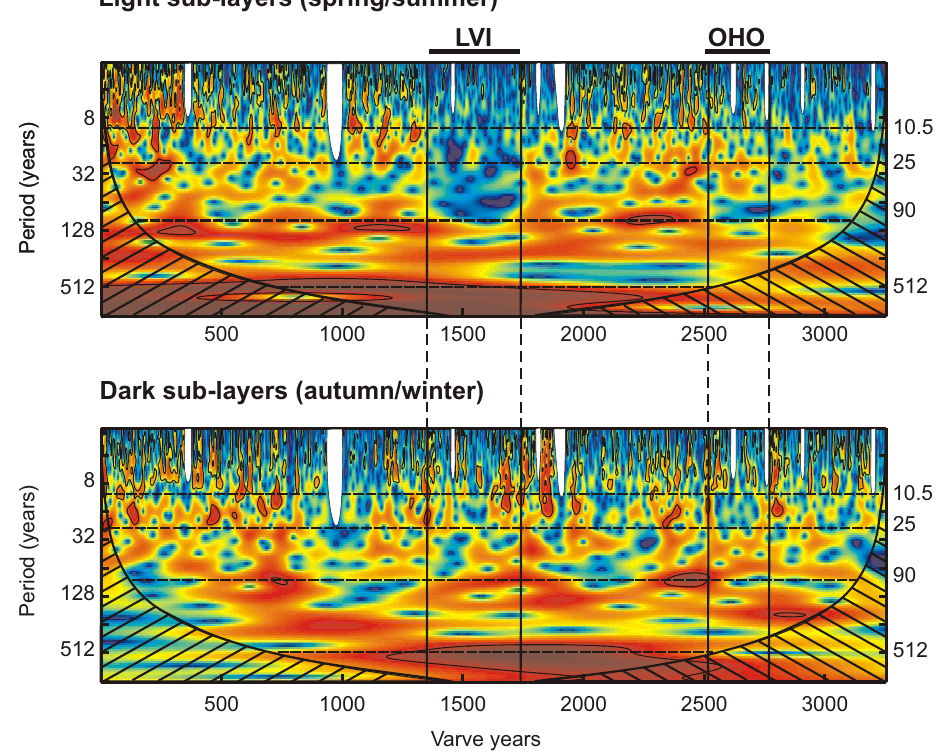
Fig. 6. Wavelet power spectra of the light and dark sub-layer thickness measurements. Wavelet amplitudes are colour coded from red (high power) to blue (low power). Contoured areas exceed the 95% confidence levels for a red noise background spectrum. Hatched areas indicate the cone of influence where wavelet analysis is affected by edge effects. Dashed lines mark the solar-like periodicities. White cones indicate intervals with no varve-thickness data. Positions of the Older Holsteinian Oscillation (OHO) and the Low Variability Interval (LVI) are indicated (see Sect.